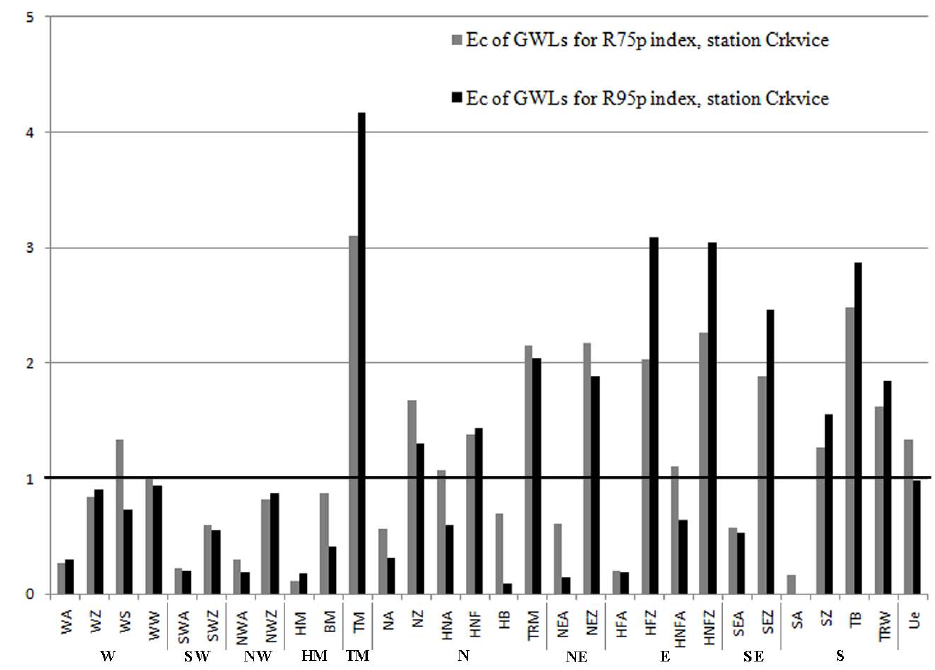
Fig. 7. The efficiency coefficient ( E c ) of GWLs for R75p and R95 in station Crkvice, period 1951–2007.